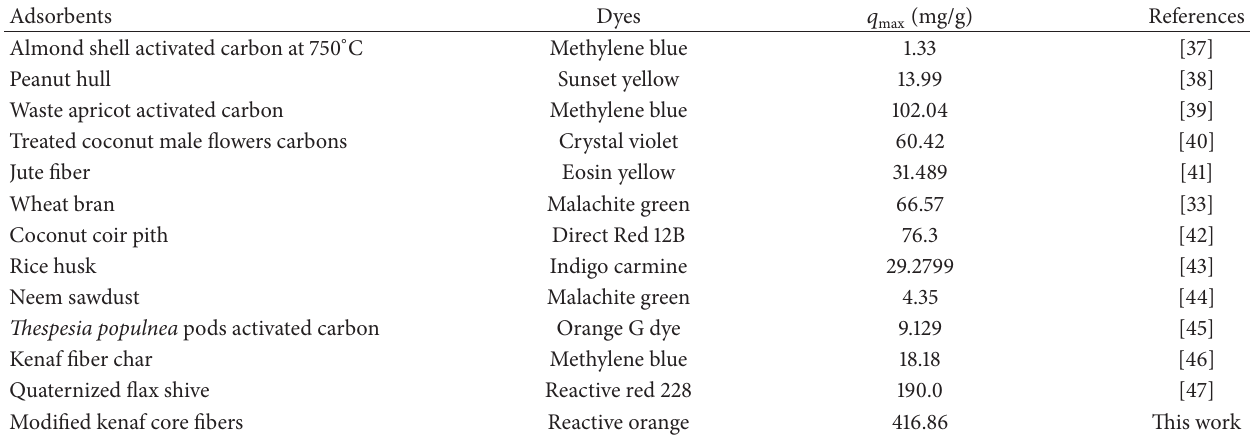
Table 1: Previous studies of uptake of dyes using adsorbents based on agricultural solid wastes.